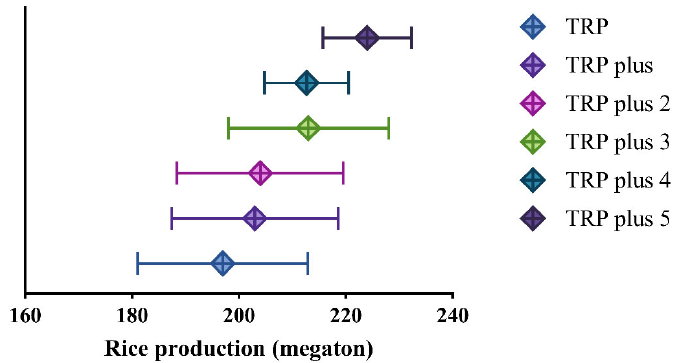
Figure 10. Potential TRPs. TRP plus: transferring early rice planting area to middle rice; TRP plus 2: transferring late rice planting area to middle rice; TRP plus 3: transferring early and late rice planting area to middle rice; TRP plus 4: transferring TRP plus 3 with mean EGPA; TRP plus 5: transferring TRP plus 3 with max EGPA. Error bars are standard deviations.